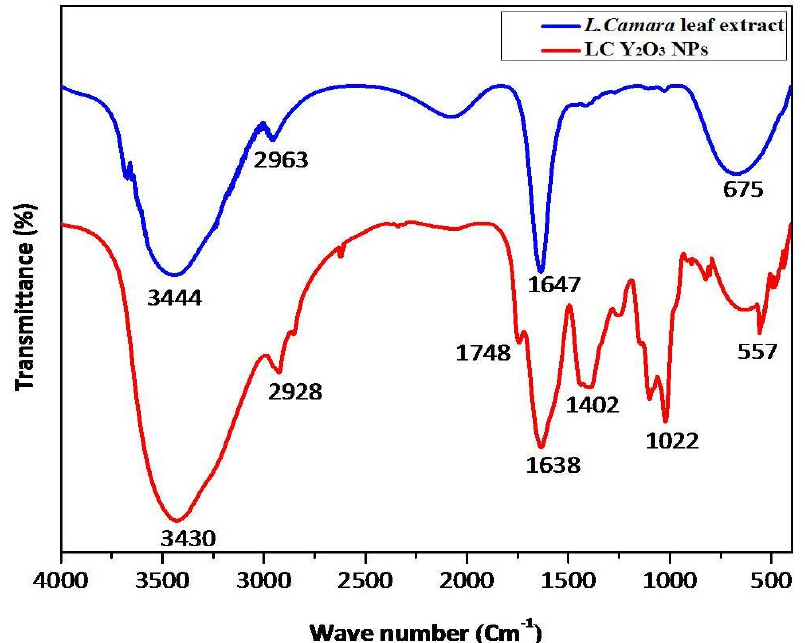
Figure 2. FTIR spectrum of the L. camara leaf extract and green-synthesized LC Y 2 O 3 NPs.